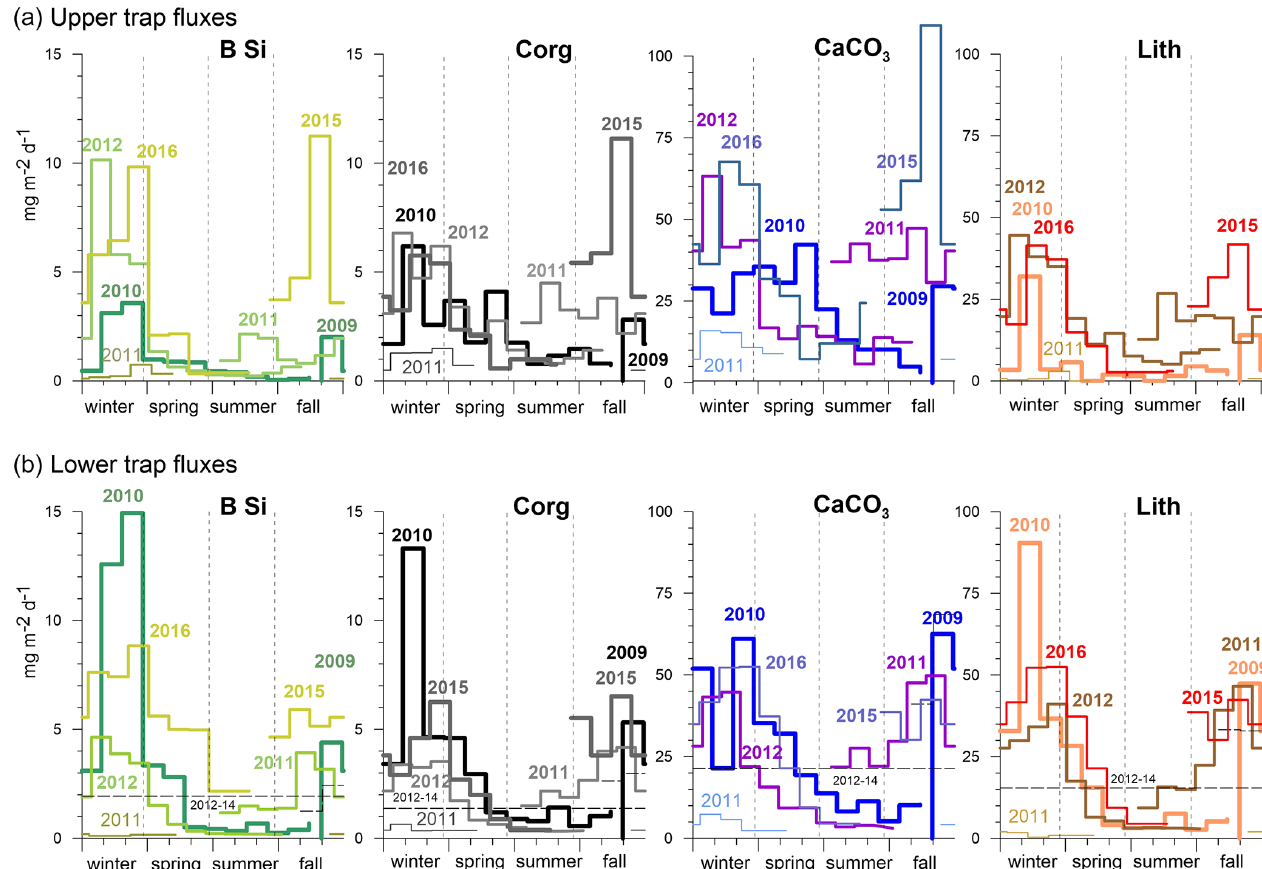
Figure 7. Upper (a) and lower (b) trap seasonal flux patterns of BSi, organic carbon, carbonate and lithogenic fluxes on a Julian day scale. In 2013, only one sampling cup was available and collected all the material (Table 1). Note the overall higher seasonality recorded in the lower traps (b) and for BSi at both trap depth levels. During the oligotrophic winter–spring 2011, fluxes remained low compared to the other years, revealing almost no